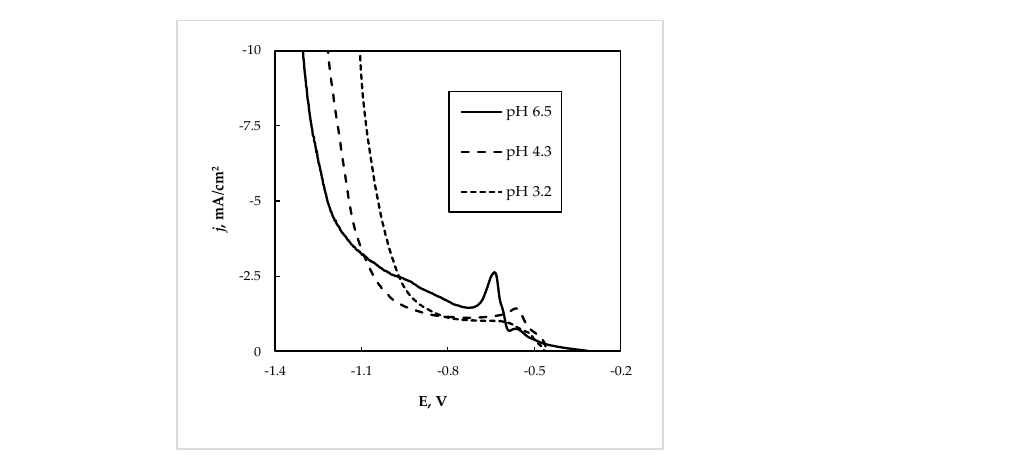
Figure 7. Cathodic polarization curve on Sn electrode at 60 °C and scan rate 5 mV/s from the leachate “L1”. Table 2. The composition of deposits obtained at − 0.85 V and 60 °C from leachate “L1”at various pHs.